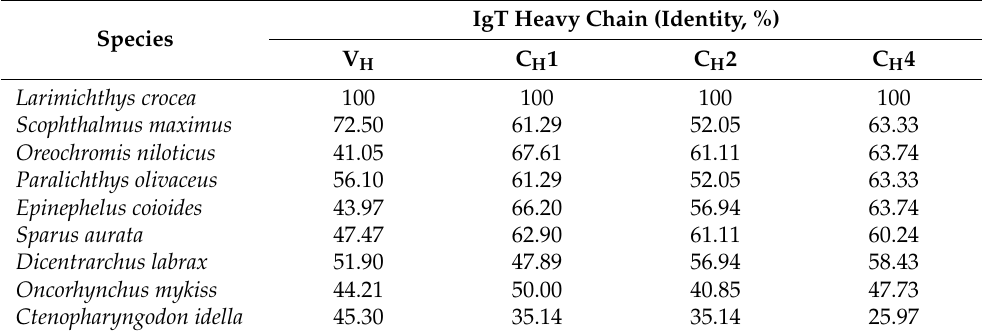
Table 2. The amino acid identity analysis of the V H and each C H domain of IgT heavy chain between L. crocea and other fish